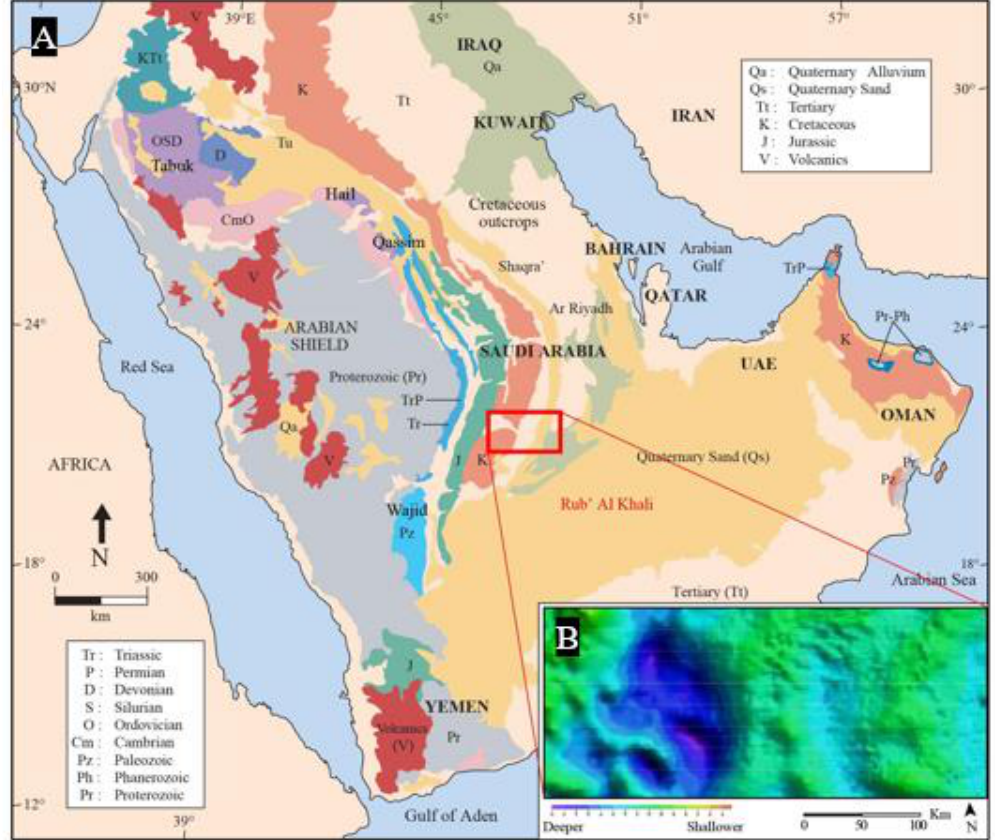
Figure 1. ( A ) Surface geological map of the Arabian Plate, ( B ) gravity map showing the basement topography underneath the study area.